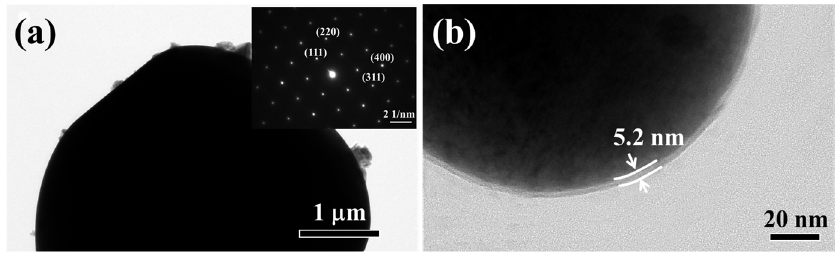
Figure 5. The TEM images and corresponding selected area electron diffraction (SAED) of the ( a ) LMO-B and ( b )